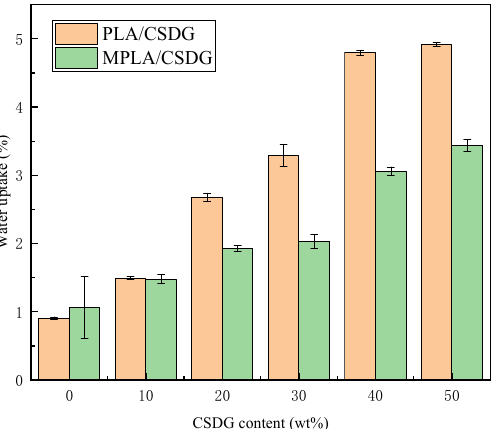
Figure 13. Water uptake for PLA/CSDG and MPLA/CSDG